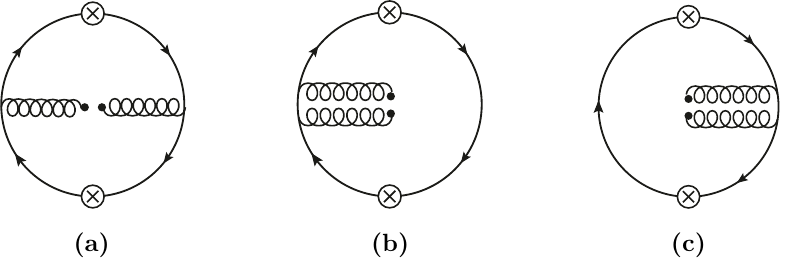
Figure 13. Feynman diagrams of the contributions of the gluon condensate to the two-point Green functions. The diagram 13(a) contains two propagators (6.2b) and the diagrams 13(b){13(c) one propagator